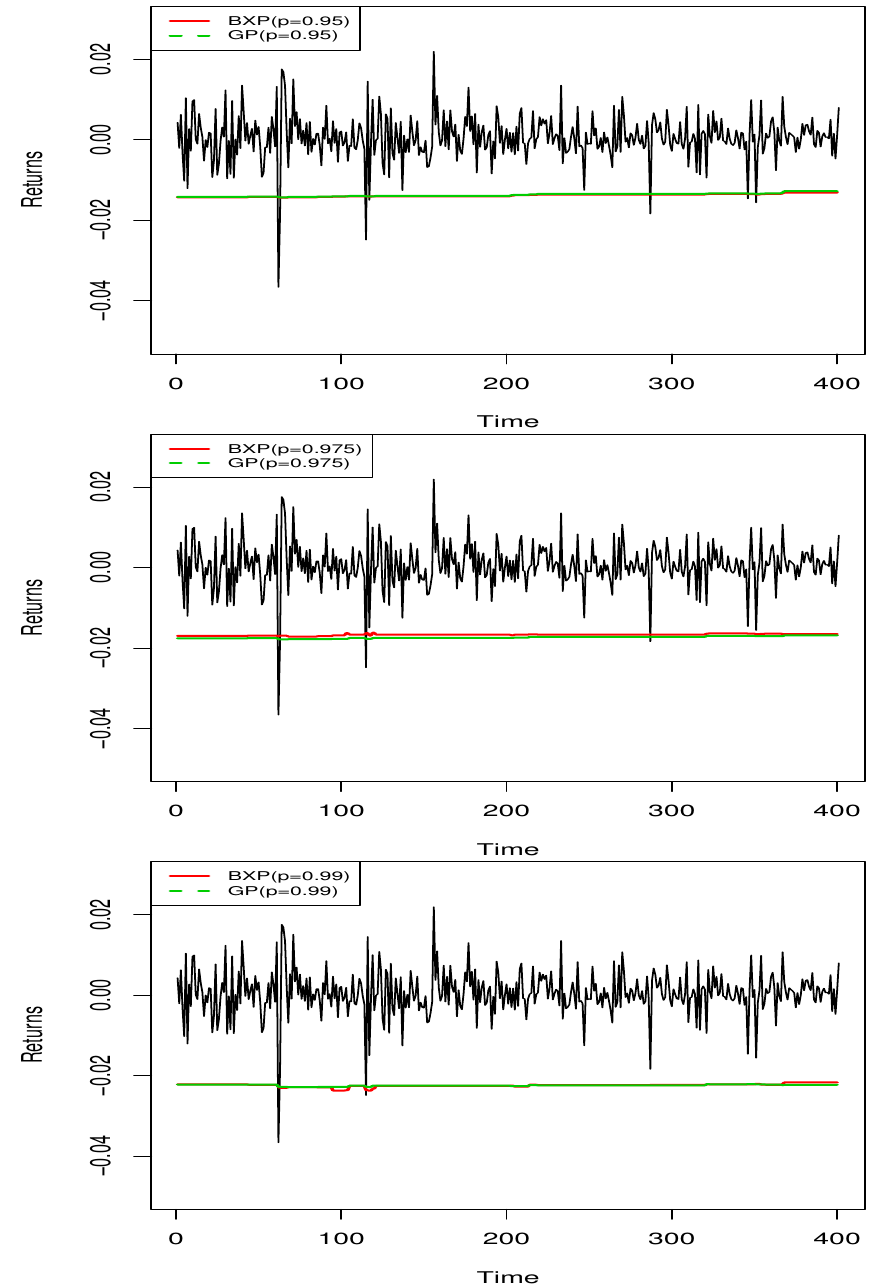
Figure 6. Daily VaR estimates of the BXP and GP